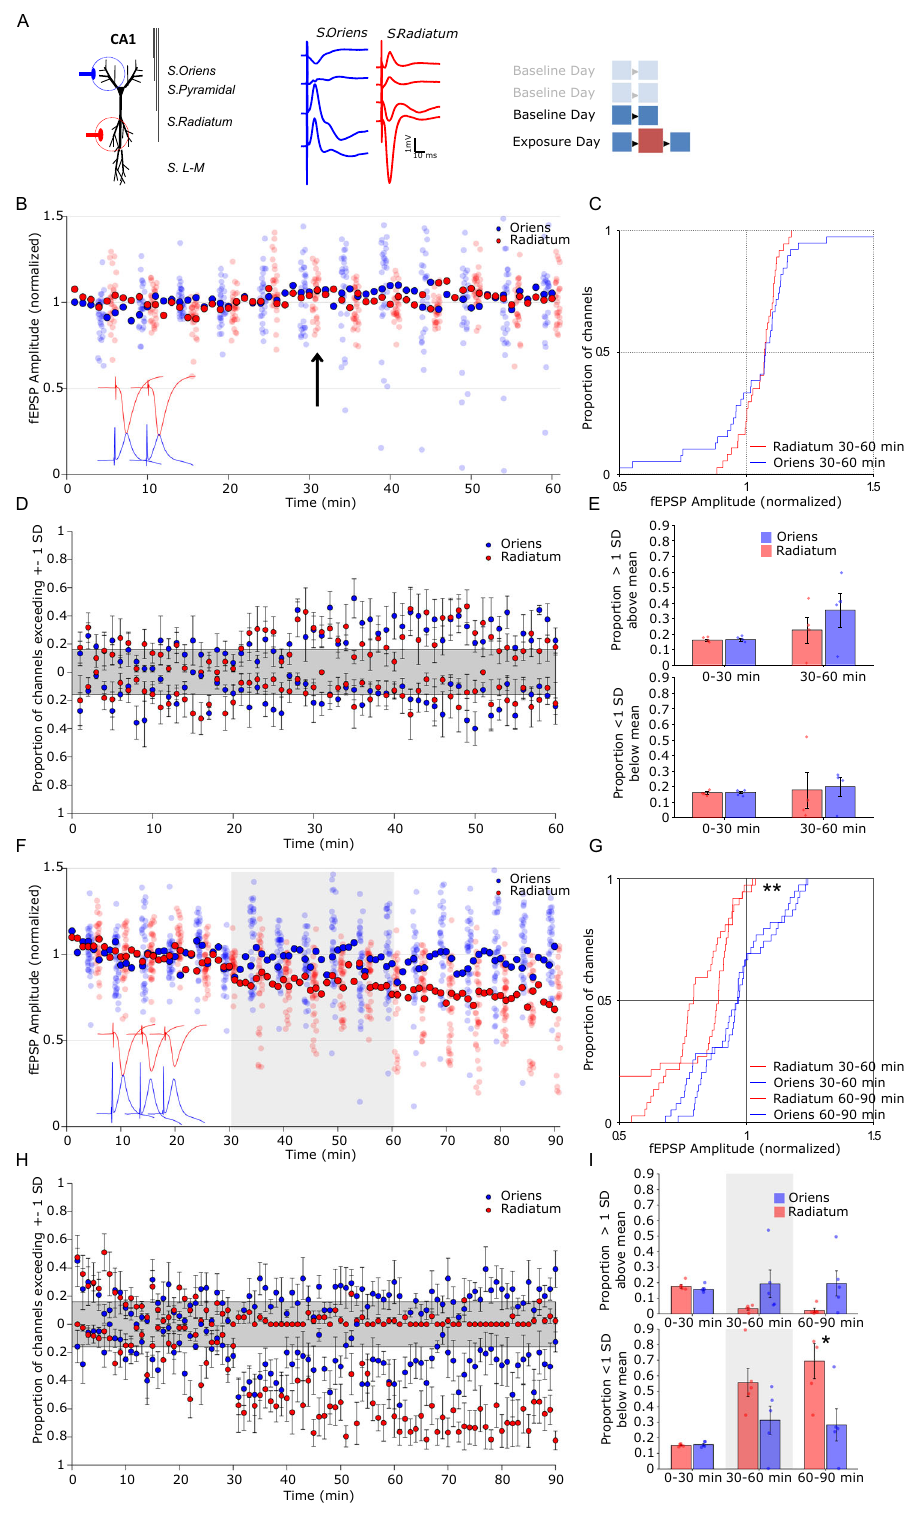
effect of drug treatment was observed in the oriens pathway on the re-exposure day (Supplementary Fig. 2; Supplementary Table 1). Together these results show that novel environment exposure produces a de novo reduction in fEPSP magnitude in the apical inputs to CA1 that is mediated by activity-dependent AMPA receptor endocytosis, a well-characterized mechanism for LTD expression 31,32 . The novel environment elevated locomotion